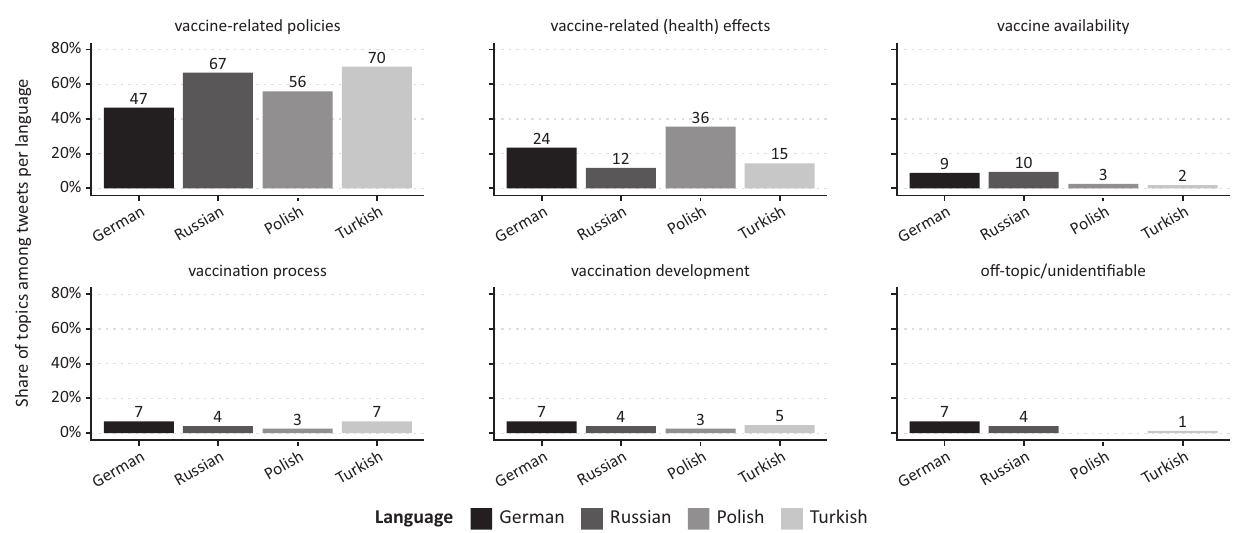
Figure 2. Topic distribution for all coded tweets. Notes: n = 3,205, German ( n = 2,658), Russian ( n = 420), Turkish ( n = 88), Polish ( n = 39); Cramer’s V = 0.1; p < 0.01.